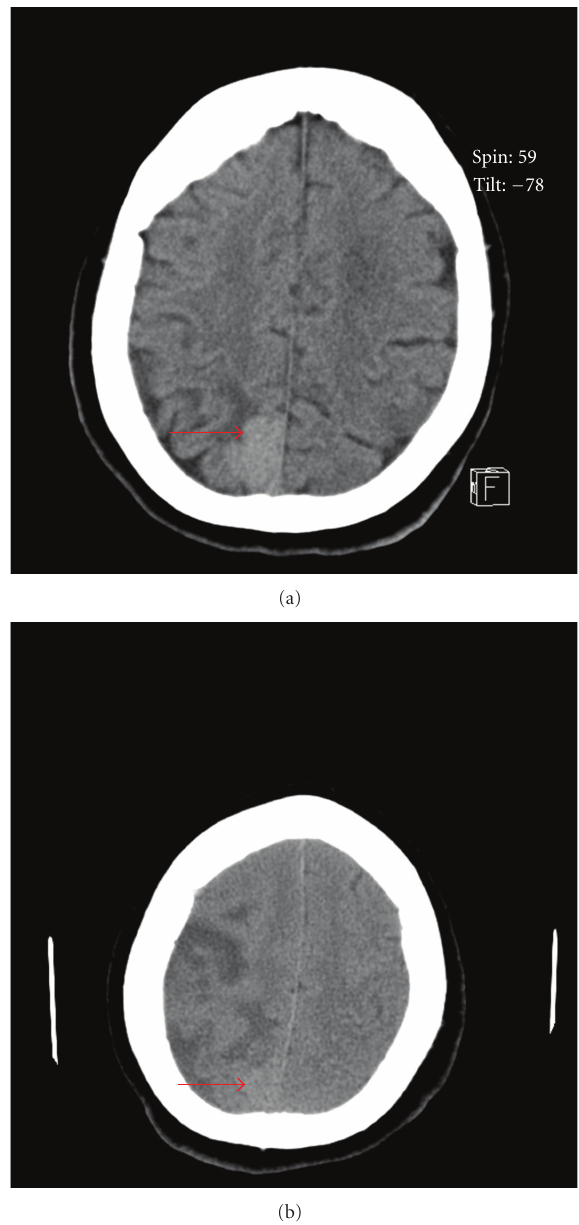
Figure 2: (a) Initial head CT showing parafalcine mass (arrow). (b) Head CT 36 hours after